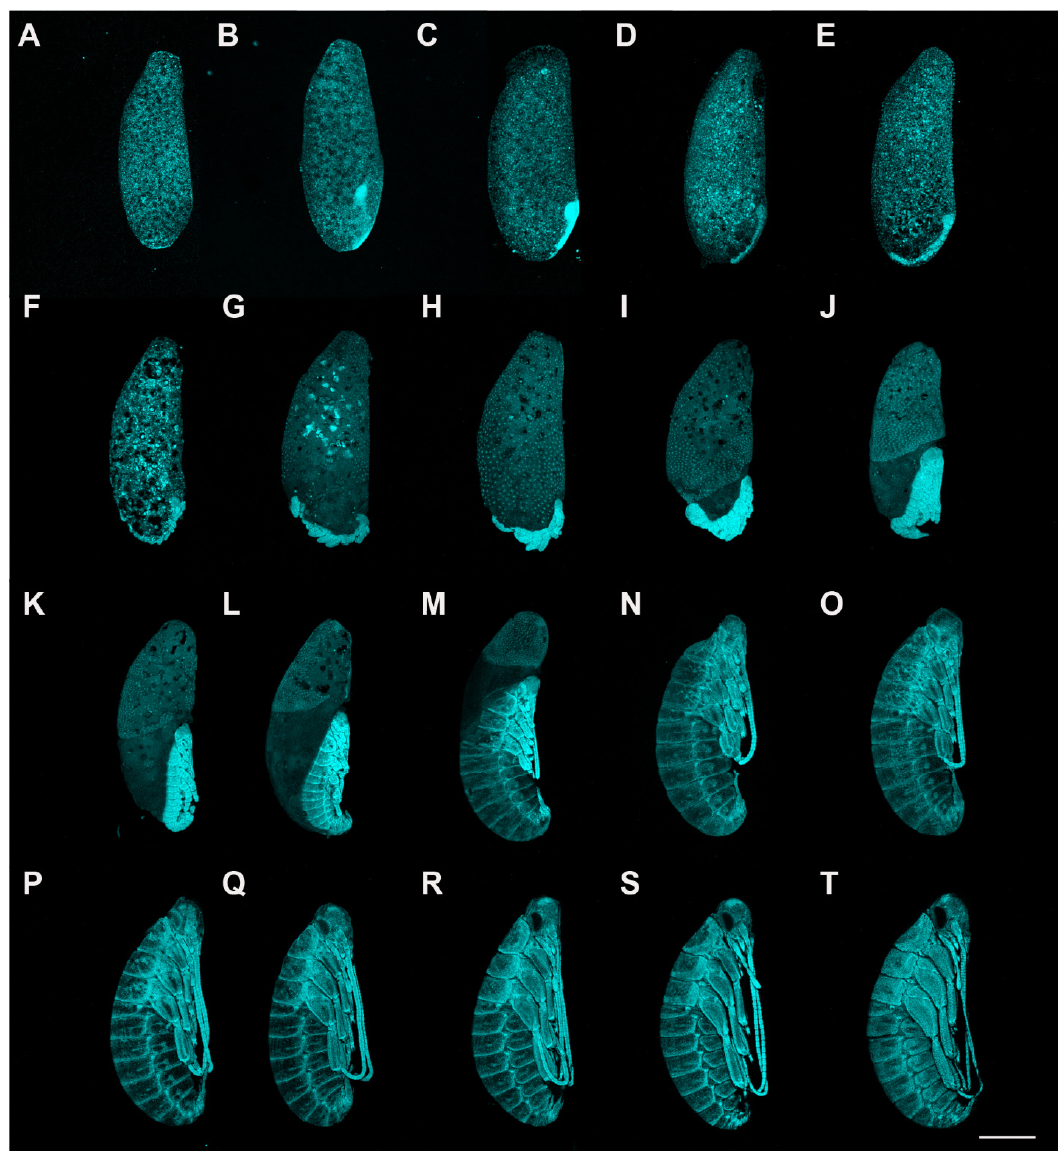
Figure 1. Embryonic development of P. americana (overview). Lateral views, ventral to the right. Fluorescence images with DAPI-stained nuclei are shown. ( A ) Stage 1. ( B ) Stage 2. ( C ) Stage 3. ( D ) Stage 4. ( E ) Stage 5. ( F ) Stage 6. ( G ) Stage 7. ( H ) Stage 8. ( I ) Stage 9. ( J ) Stage 10. ( K ) Stage 11. ( L ) Stage 12. ( M ) Stage 13. ( N ) Stage 14. ( O ) Stage 15. ( P ) Stage 16. ( Q ) Stage 17. ( R ) Stage 18. ( S ) Stage 19. ( T ) Stage 20. Scale bars: 1000 μ m.